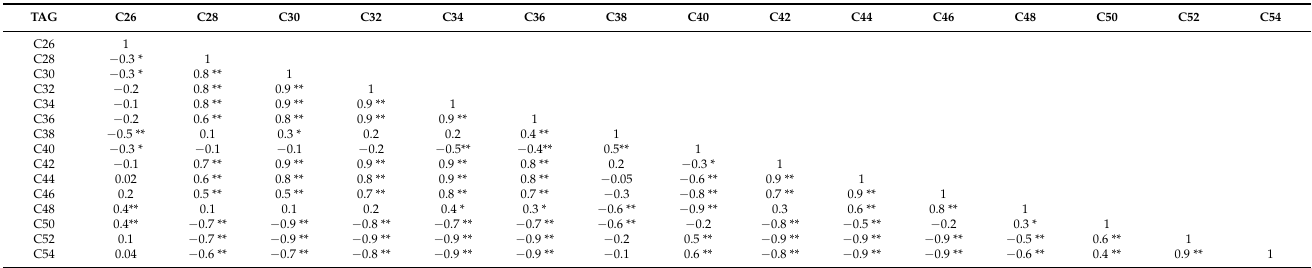
Table 3. Correlations between TAG of milk (PU 1, 2, 3, and CT) produced in Tecpat á n,